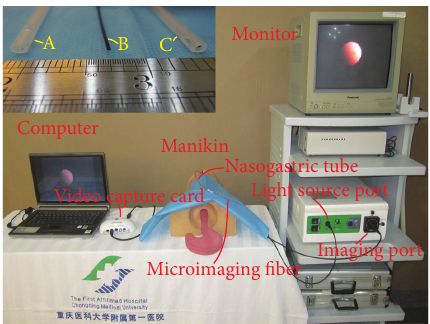
Figure 1: Laboratory human analog model test setup for the visual nasogastric tube insertion system (VNGS). A: nasogastric tube (outer diameter: 4mm). B: microimaging fiber (outer diameter: 0.8 mm). C: microimaging fiber inserted into the nasogastric